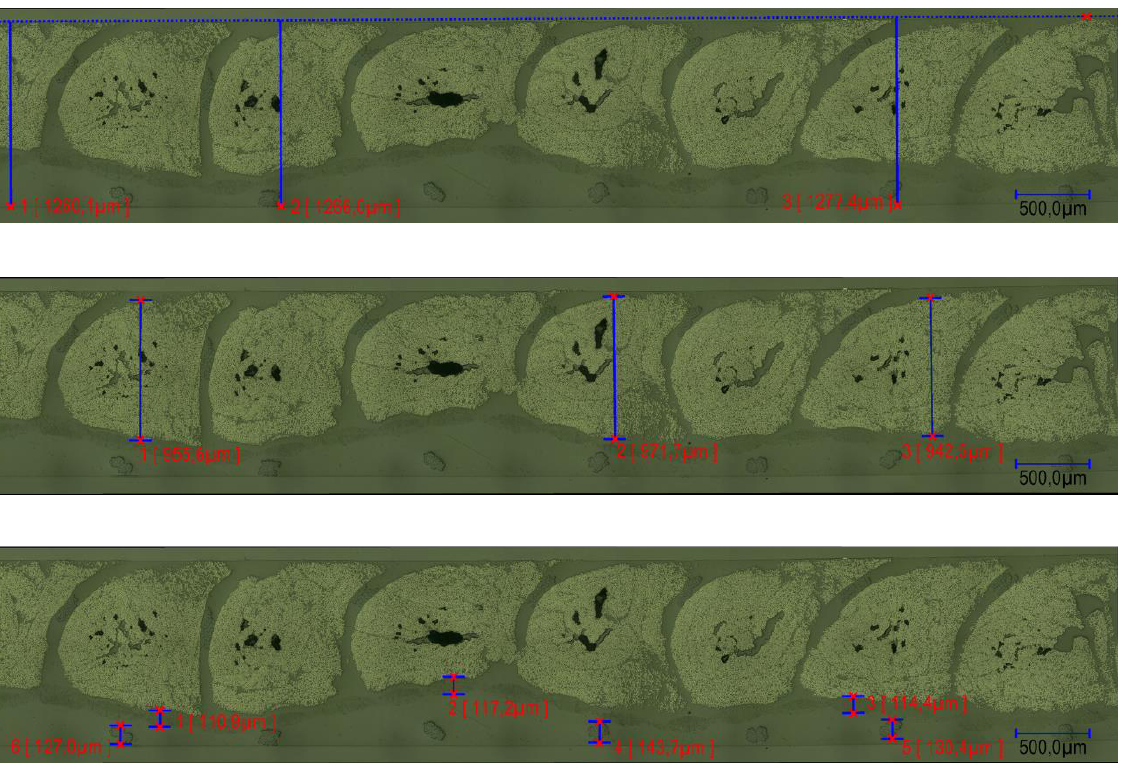
Figure 8. Examples of measurements of distance in specific regions at several places of a microsection: overall ( top ), roving ( middle ), and base-material and thread thicknesses ( bottom